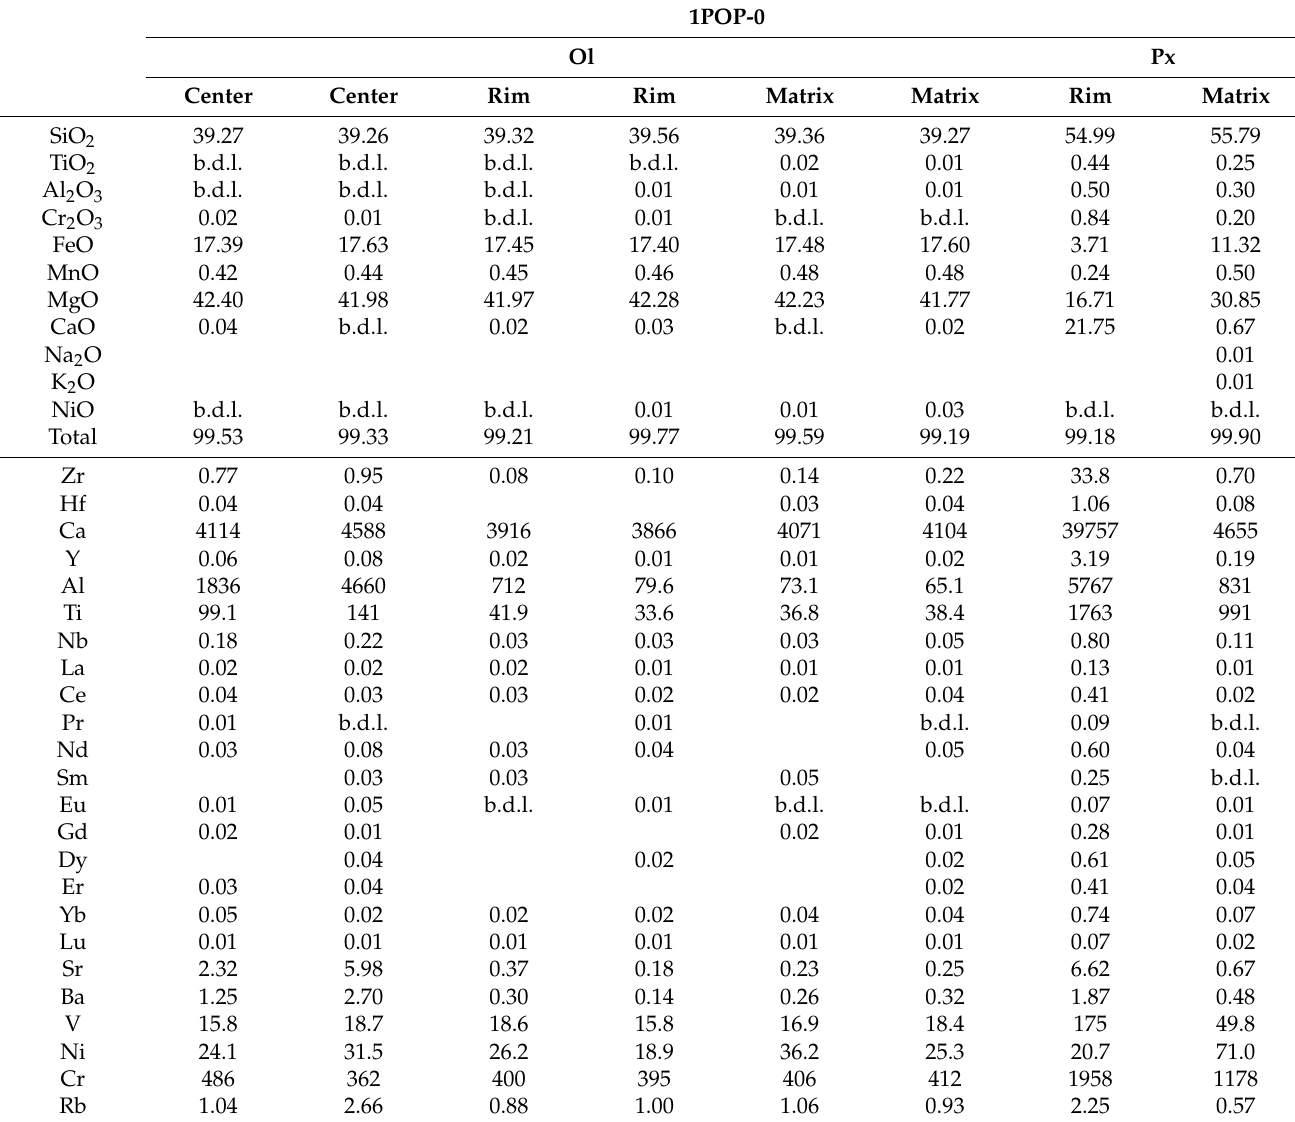
Table 2. Major (measured by EPMA, in wt.%) and trace (measured by SIMS, in ppm) elements in silicate minerals of 1POP-0 chondrule from the Kargapole meteorite. 1POP-0 Ol Px Center Center Rim Rim Matrix Matrix Rim Matrix